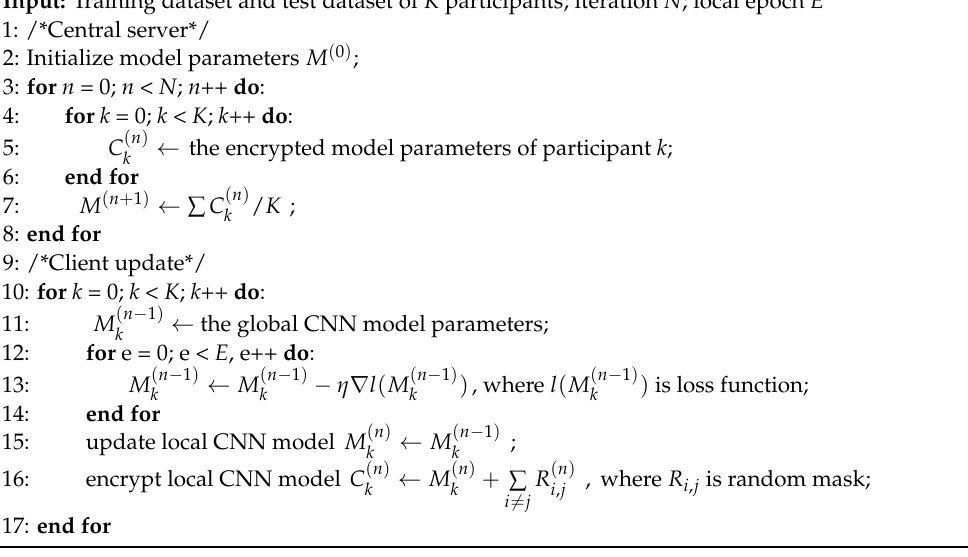
Algorithm 1 HomoCNNb (Horizontal Convolution Neural Network)